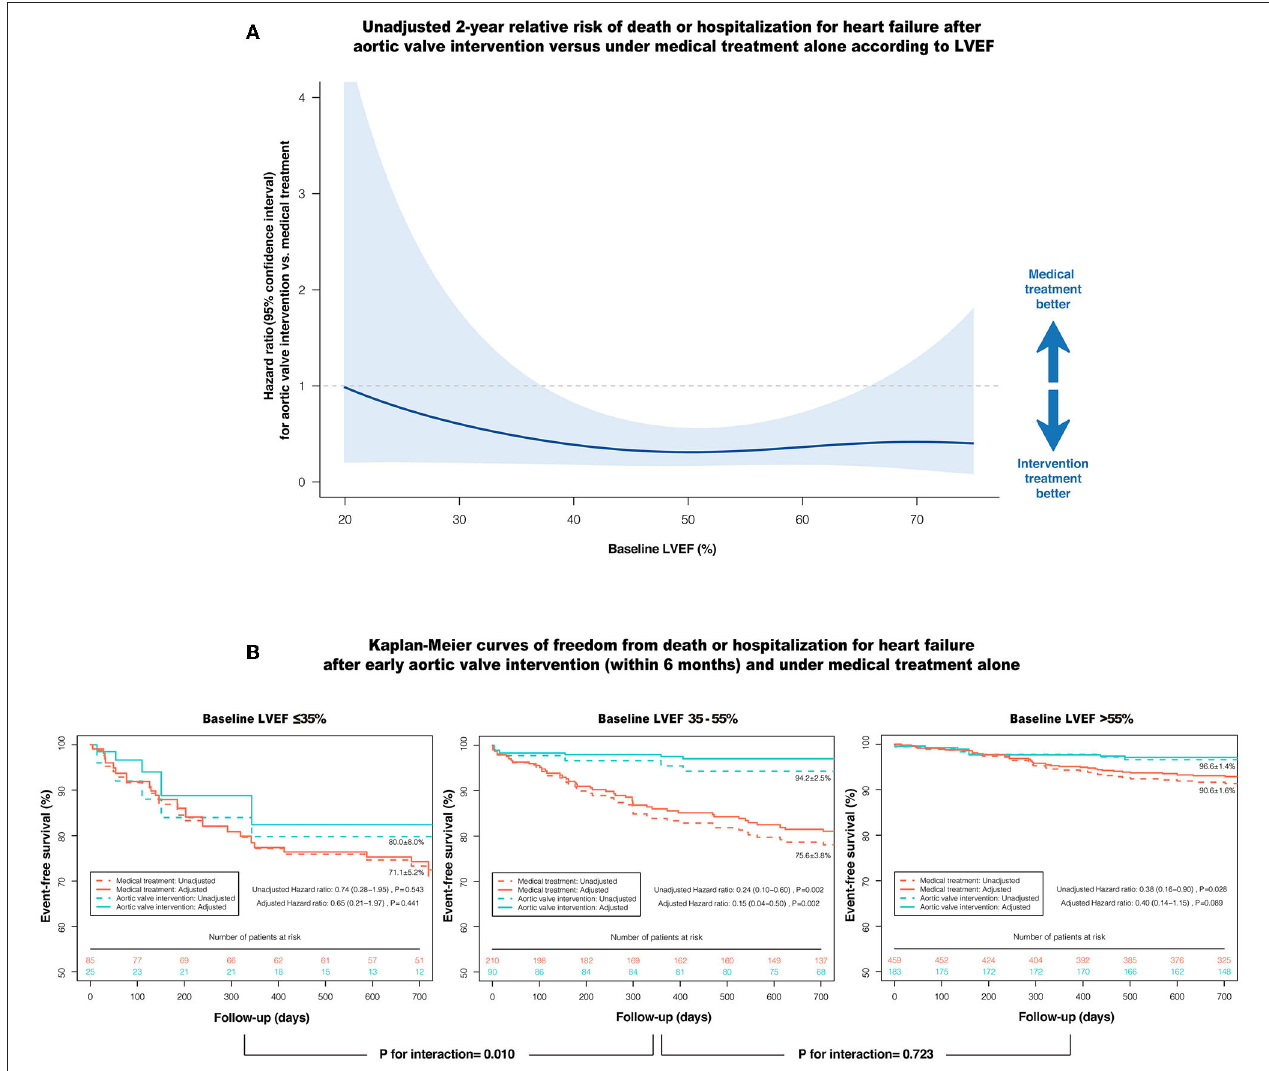
FIGURE 3 | Impact of AVI on the composite of death or HHF according to baseline LVEF. (A) The unadjusted relative risk of death or HHF after AVI vs. under medical treatment alone according to LVEF, with 95% confidence interval. The shaded area entirely below the horizontal line (HR = 1) denotes the upper bound of the 95% confidence interval is < 1, indicating AVI is prognostically more favorable at this LVEF. (B) Kaplan-Meier curves of event-free survival after early AVI (within 6 months) and under medical treatment alone according to the LVEF ranges, with (solid line) and without (dashed line) inverse probability treatment weighting adjustment. AVI, aortic valve intervention; HHF, hospitalization for heart failure; LVEF, left ventricular ejection